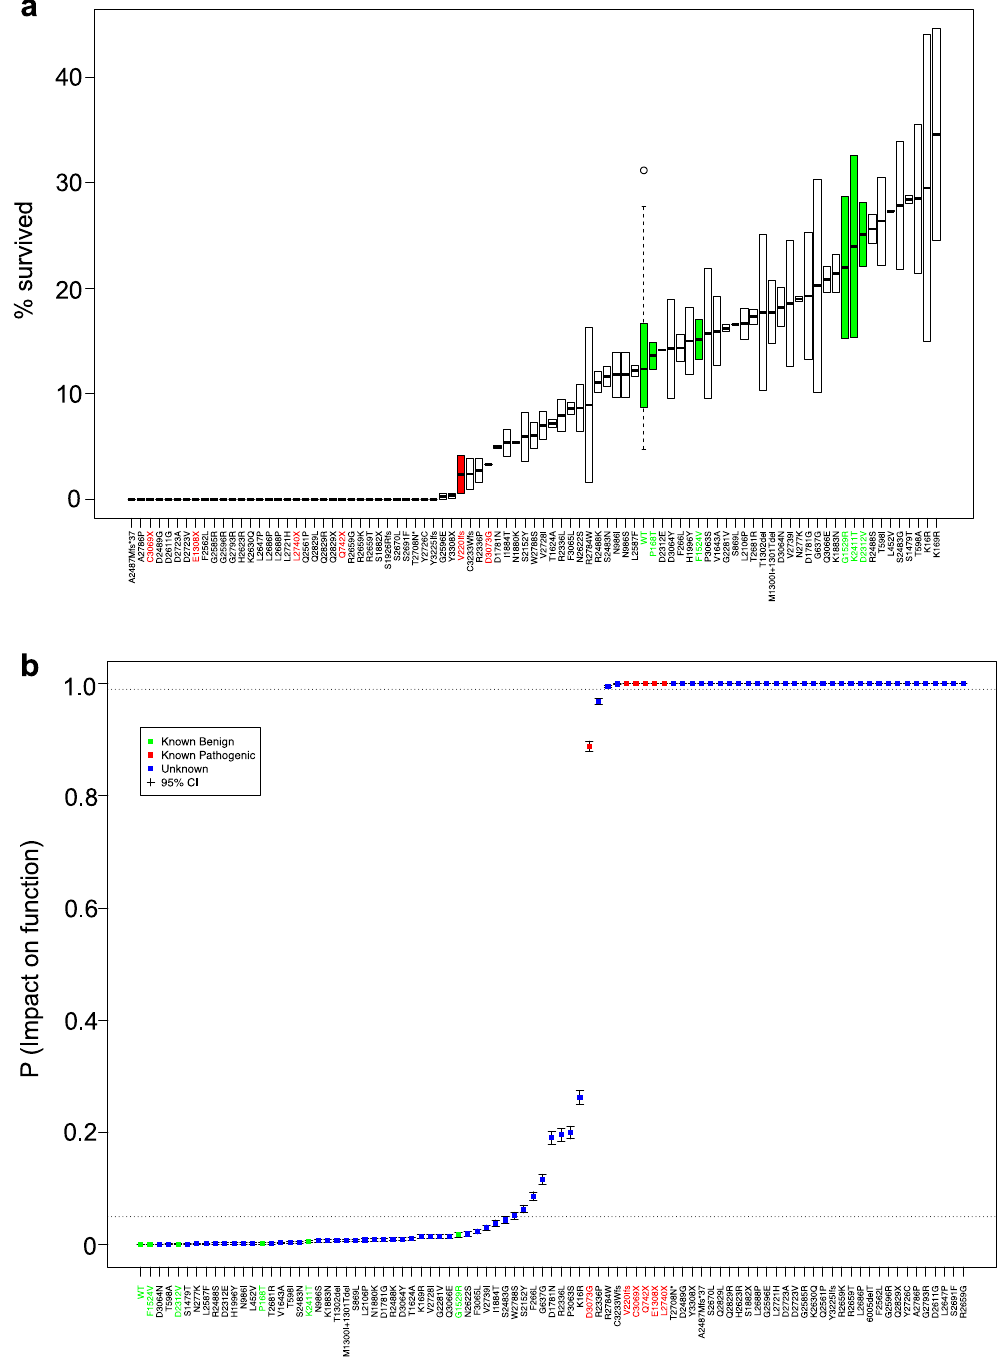
Fig. 2 Probability of impact on function (PIF) estimates of cell survival. a Cell survival fractions are plotted for each variant ordered by average survival fraction. Known neutral variants are highlighted in green and known pathogenic variants are highlighted in red. The box plotted for each variant range from the lower replicate value up to the upper replicate value with the mean value highlighted at the midpoint; for the WT we have plotted a box and whisker plot of the distribution of WT values across batches (the box ranges from the fi rst-to-third quartile with a horizontal line plotted at the median, whiskers extend from the box down to the smallest value and from the box up to the largest value within ±1.5 standard deviations of the median and points beyond this limit are depicted individually). b A plot of the estimated PIFs from the cell survival data VarCall model, depicted in increasing order. Posterior mean estimates are plotted as dots; whiskers extend from the lower to upper limits of 95% posterior credible signatures among the known benign (highlighted in green) and groups are distinct with lower values corresponding to greater among the known pathogenic variants (red) (Fig. 3b). These are sensitivities (depicted in red and dark orange) typical of the left, segregated into the two main clusters de fi ned by the top loss-of-function cluster and lesser sensitivities (light oranges and branching in the dendrogram; the effects pro fi les of the two yellows) typical of the functionally unimpaired cluster on the right.